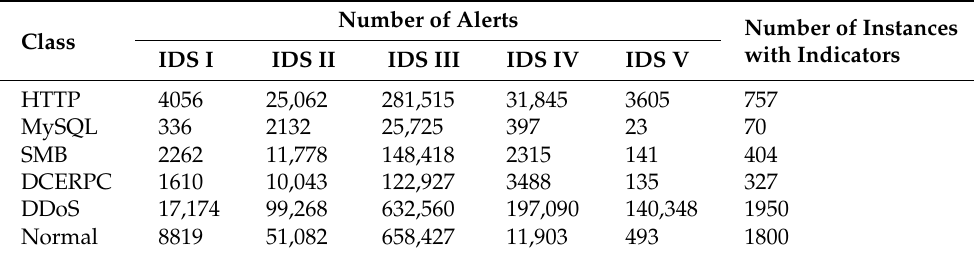
Table 4. Instance reduction of applying